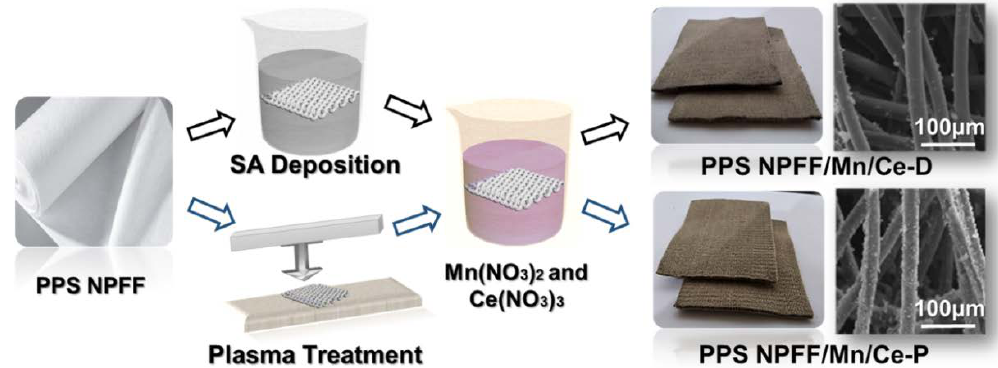
needle-punching fibrous felts